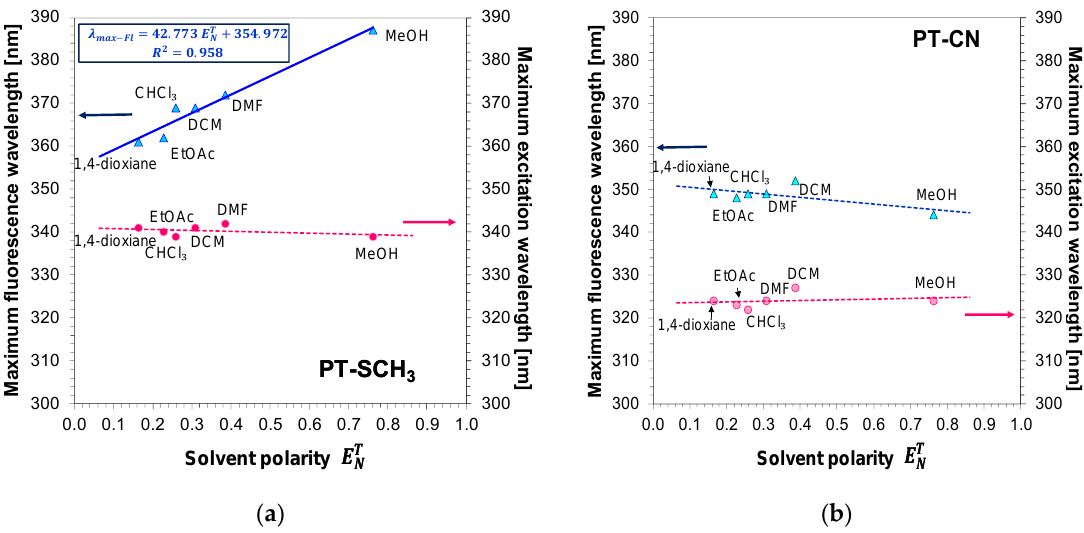
Figure 6. Dependence of the location of the maximum intensity of the emission and excitation spectra for ( a ) 2,6-bis(4-methylsulphanylphenyl)pyridine (PT-SCH 3 ) and ( b ) 2,6-bis(4-cyanophenyl)pyridine (PT-CN) on the polarity of the solvents (scale 𝐸 𝑁𝑇 ).